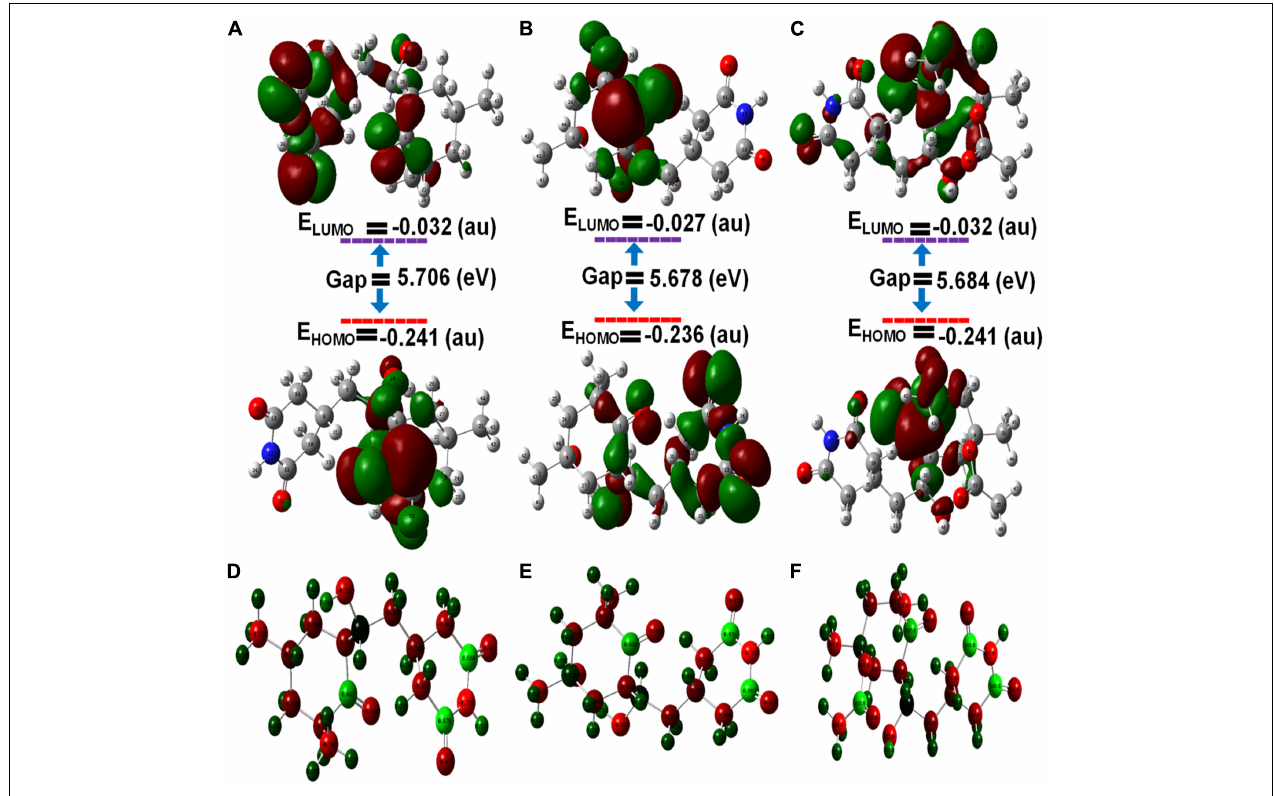
FIGURE 5 | Optimized molecular geometries with (A) cycloheximide, (B) hydroxycycloheximide, and (C) acetoxycycloheximide were calculated using the DFT approach and structures were optimized with the charges and atomic numbers (D–F) of cycloheximide, hydroxycycloheximide, and acetoxycycloheximide. The optimized structures are labeled with an atom